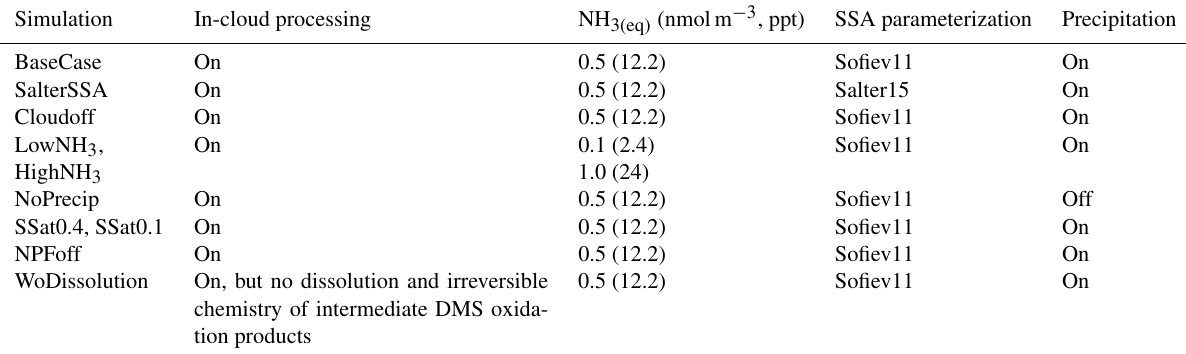
Table 1. Model sensitivity tests performed alongside the main BaseCase simulations to test the effect of different parameters on secondary aerosol formation. These sensitivity tests focus on the role of in-cloud processing and aqueous-phase chemistry, the NH 3 emissions from open ocean, SSA parameterization, and cloud supersaturation. The sea surface equilibrium NH 3(g) concentrations in parts per trillion are provided in the